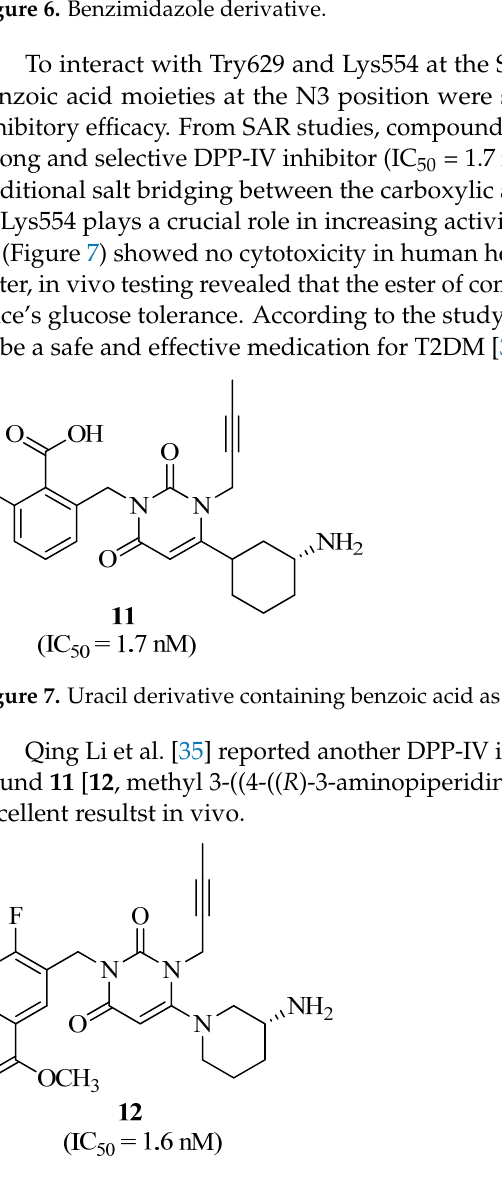
Figure 8. Aminopiperidin-dioxopyrimidin derivative as DPP-IV inhibitor.